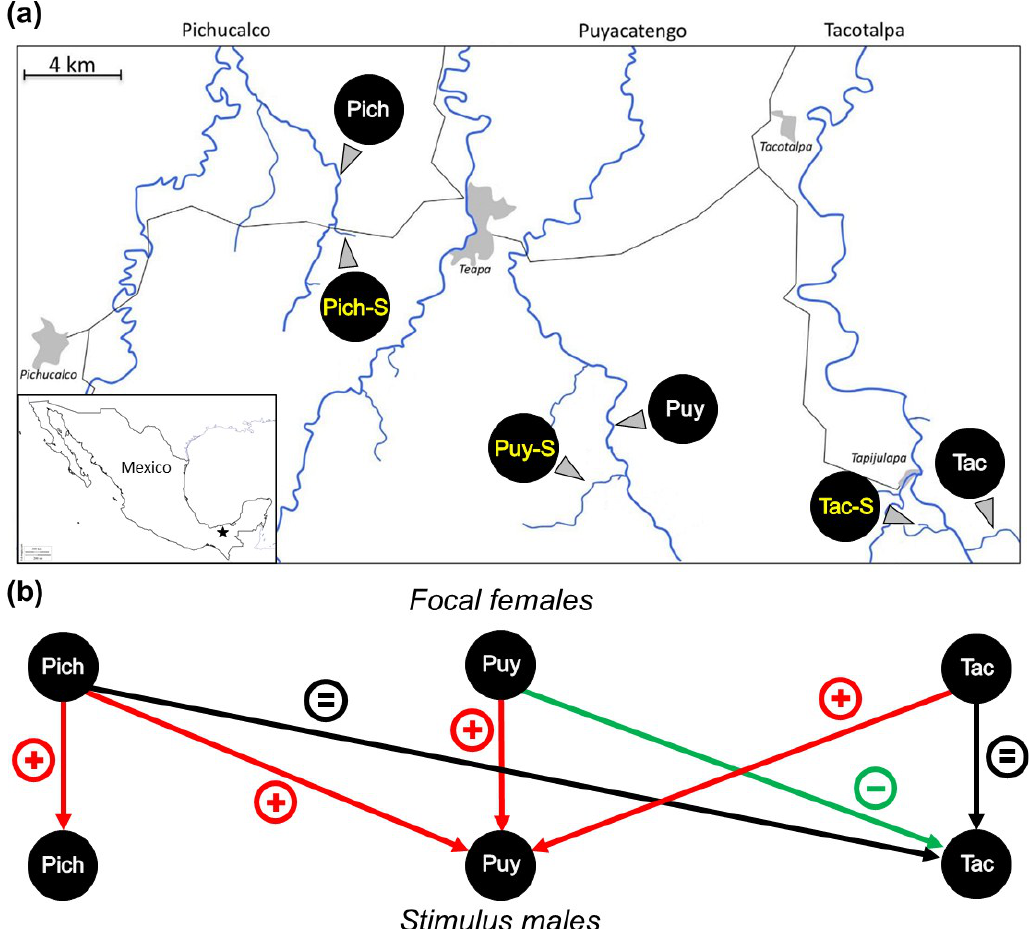
Figure 1. ( a ) Overview of our study area and sampling localities in three parallel rivers in which Poecilia mexicana and Poecilia sulphuraria were collected (from west to east: R í o Pichucalco, Pich = non-sulfidic R í o Pichucalco; Pich-S = sulfidic Baños del Azufre; R í o Puyacatengo, Puy = non-sulfidic R í o Puyacatengo road crossing; Puy-S = sulfidic La Lluvia; R í o Tacotalpa, Tac = non-sulfidic Arroyo Bonita, Tac-S = sulfidic El Azufre). All non-sulfidic sites are inhabited by P. mexicana populations, while Puy-S and Tac-S harbor locally adapted (sulfide-resistant) P. mexicana ecotypes, and Pich-S is inhabited by the closely related, sulfide-endemic P. sulphuraria ; ( b ) Summary results of binary, dichotomous association preference tests to assess female mating preferences. Focal females from non-sulfidic habitats in all three rivers were given a choice between stimulus males from their own ecotype and the sulfide-adapted ecotype. Results from tests within drainages (vertical arrows) were taken from Plath et al. [12], and we conducted additional cross-drainage tests. The arrows signify a significant deviation of females’ strength of preference (SOP) from zero (two-sided one-sample t -tests), suggesting preference for the male phenotype from non-sulfidic habitats (+), no statistically significant preference (=), or preference for the opposite (sulfide-adapted) male phenotype ( − ). Note that while Puy males were more attractive than Puy-S males within and across rivers, Tac-S males were not less attractive than Tac males, and Puy females even preferred Tac-S over Tac males.